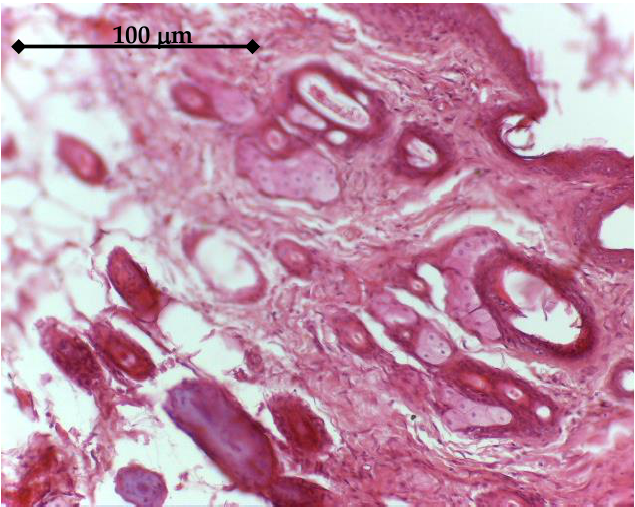
Figure 16. Tissue around BMP2 Ti sample (14 days), Hematoxylin eosin staining: Tegument with numerous bundles of collagen fibers, both in the superficial dermis and in the deep dermis, 20×.